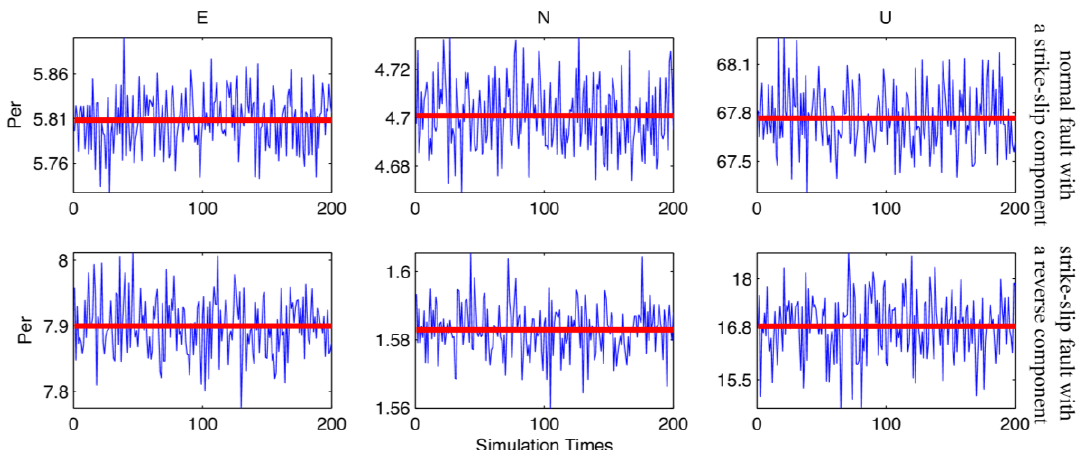
Figure 7. The improvement ratios of the VOILS method compared with the direct solution method under nine global positioning system (GPS) points for Scheme 2.